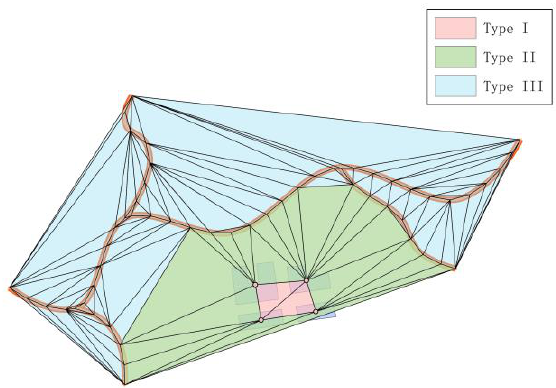
Figure 13. Construction of position